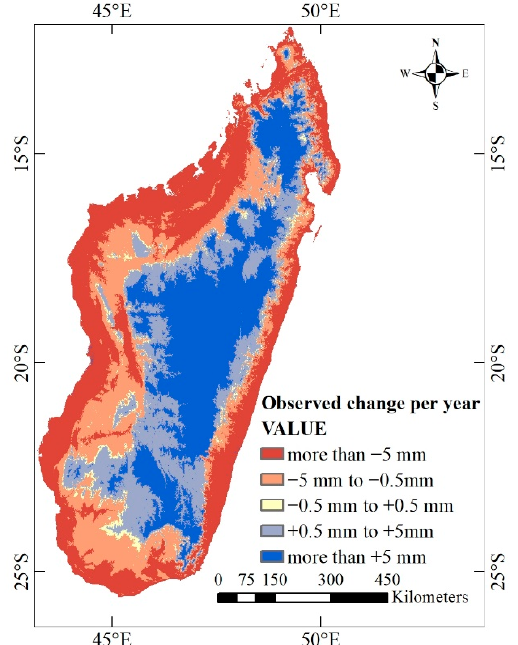
Figure 7. Observed change of rainfall according to elevation in Madagascar.